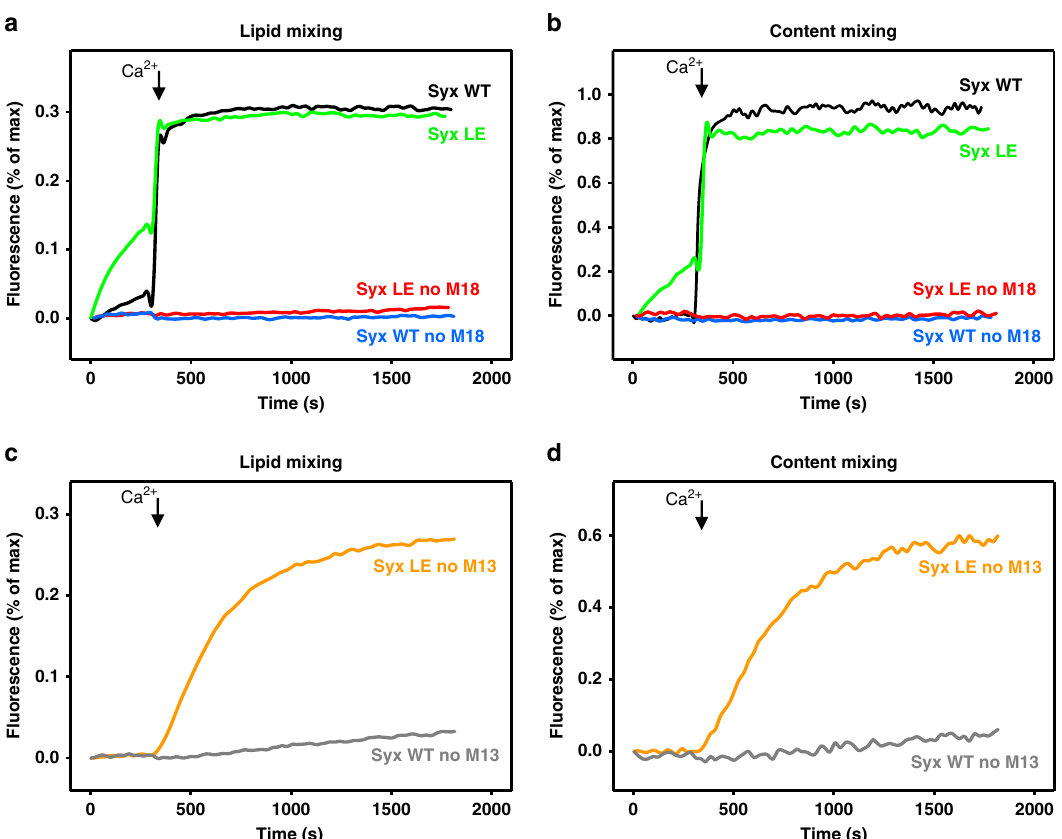
Fig. 8 The syntaxin-1 open mutant partially bypasses the requirement of Munc13-1 but not Munc18-1 for liposome fusion. a – d Lipid mixing ( a , c ) between V- and T-liposomes (containing syntaxin-1 (Syx) WT or LE open mutant) was monitored from the fl uorescence de-quenching of Marina Blue lipids and content mixing ( b , d ) was monitored from the increase in the fl uorescence signal of Cy5-streptavidin trapped in the V-liposomes caused by FRET with PhycoE-biotin trapped in the T-liposomes upon liposome fusion. In a , b , assays were performed in the presence of NSF, α SNAP, the synaptotagmin-1 C 2 AB fragment and the Munc13-1 C 1 C 2 BMUNC 2 C fragment with (green and black traces) or without (red and blue traces) Munc18-1. In c , d , assays were performed in the presence of NSF, α -SNAP, the synaptotagmin-1 C 2 AB fragment and Munc18-1, without the Munc13-1 C 1 C 2 BMUNC 2 C fragment. Experiments were started in the presence of 100 µ M EGTA and 5 µ M streptavidin, and Ca 2 + (600 µ M) was added at 300